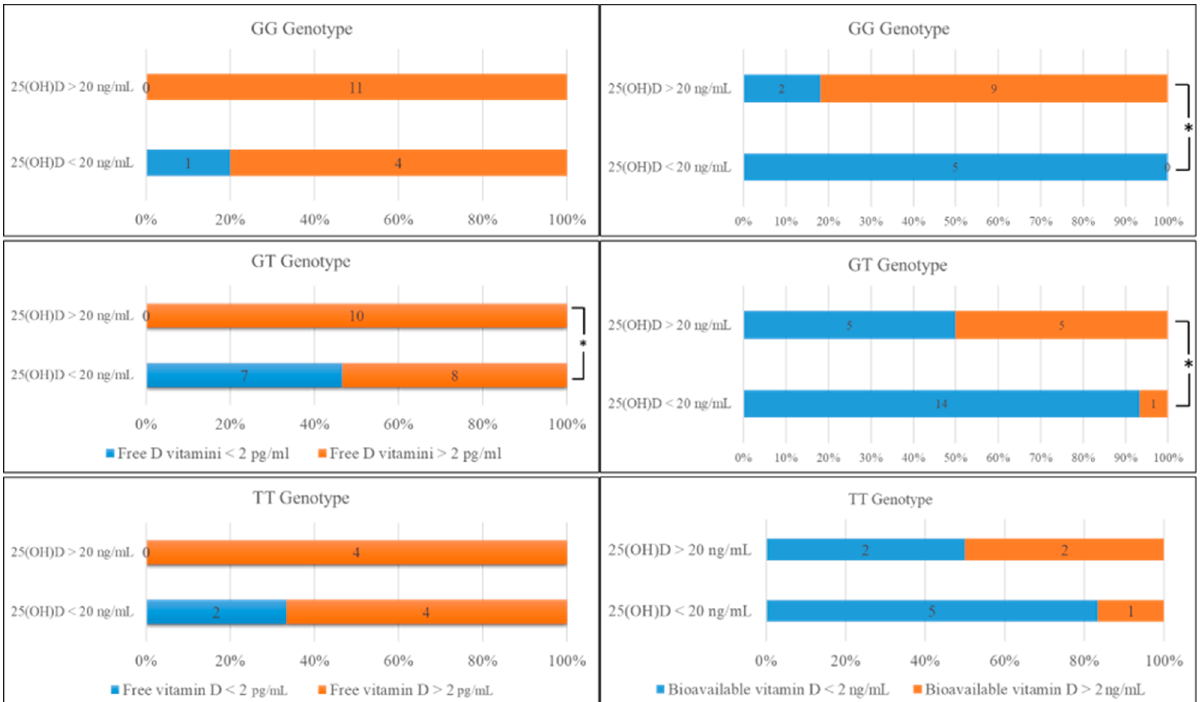
Figure 1. Comparison of the number of individuals with GG, GT, and TT genotypes according to serum 25(OH)D levels compared with the free and bioavailable 25(OH)D levels. * p < 0.05 indicates the significance